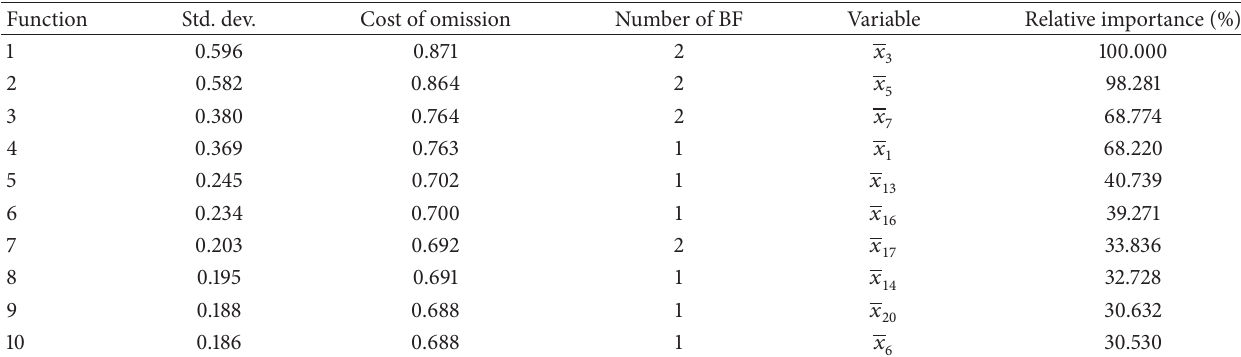
Table 5: Basis functions and important explanatory variables for the MARS model with ( 𝜌 , 𝛿 𝑖 ) = (0.5, 0.5). Function Std. dev.